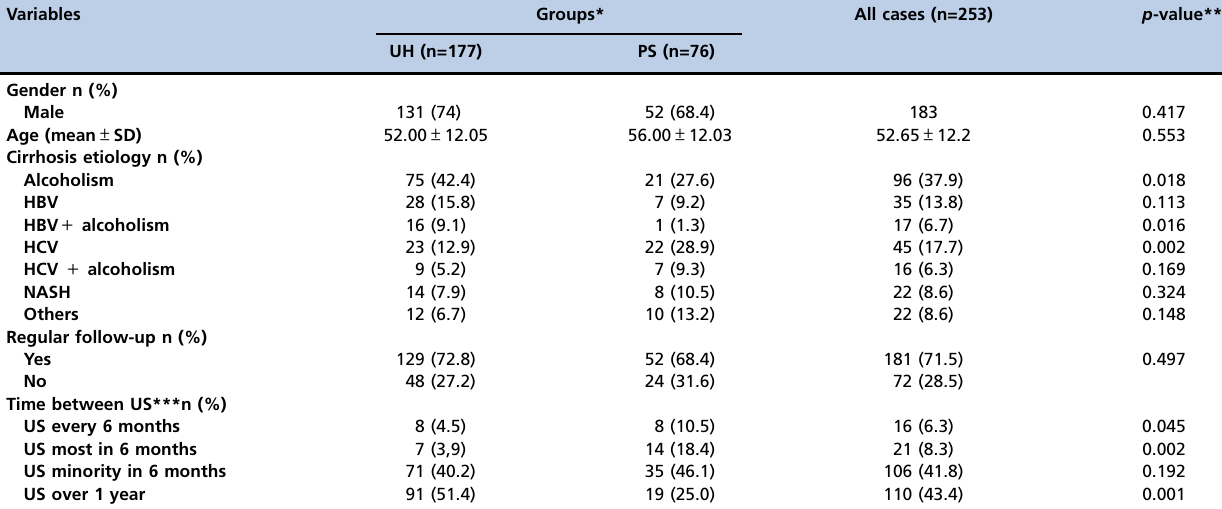
Table 1 - Demographic data, etiologies of liver cirrhosis and regularity of ultrasound performance according to type of public and private patients. Variables